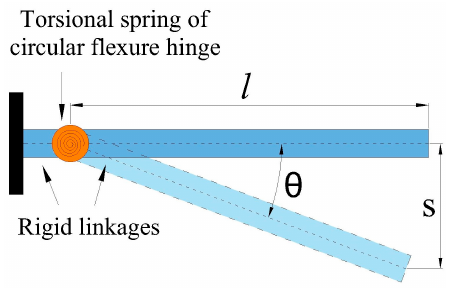
Figure 2. Equivalence of a circular flexure hinge to the PRBM.